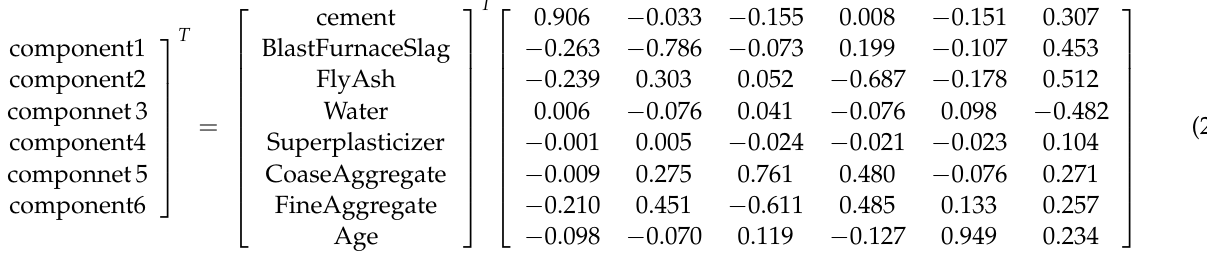
Figure 14. Prediction accuracy of ANN with different neurons in each layer: ( a ) training set and ( b ) test set